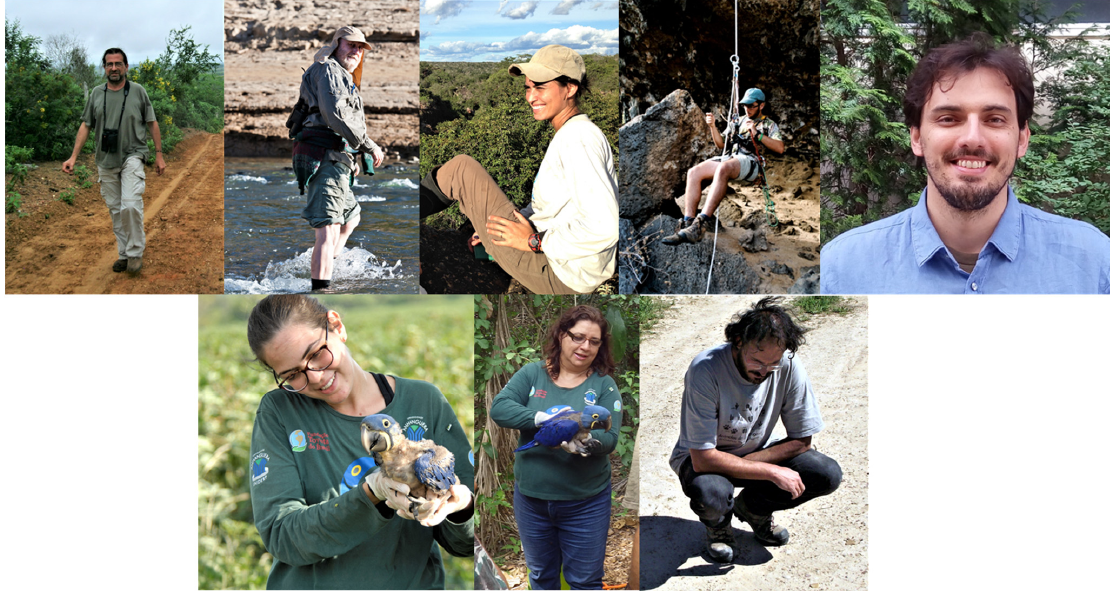
Figure 4. José L. Tella, Fernando Hiraldo, Erica Pacífico, José A. Díaz ‐ Luque, Francisco V. Dénes, Fernanda M. Fontoura, Neiva Guedes and Guillermo Blanco (from up to down and from left to right).